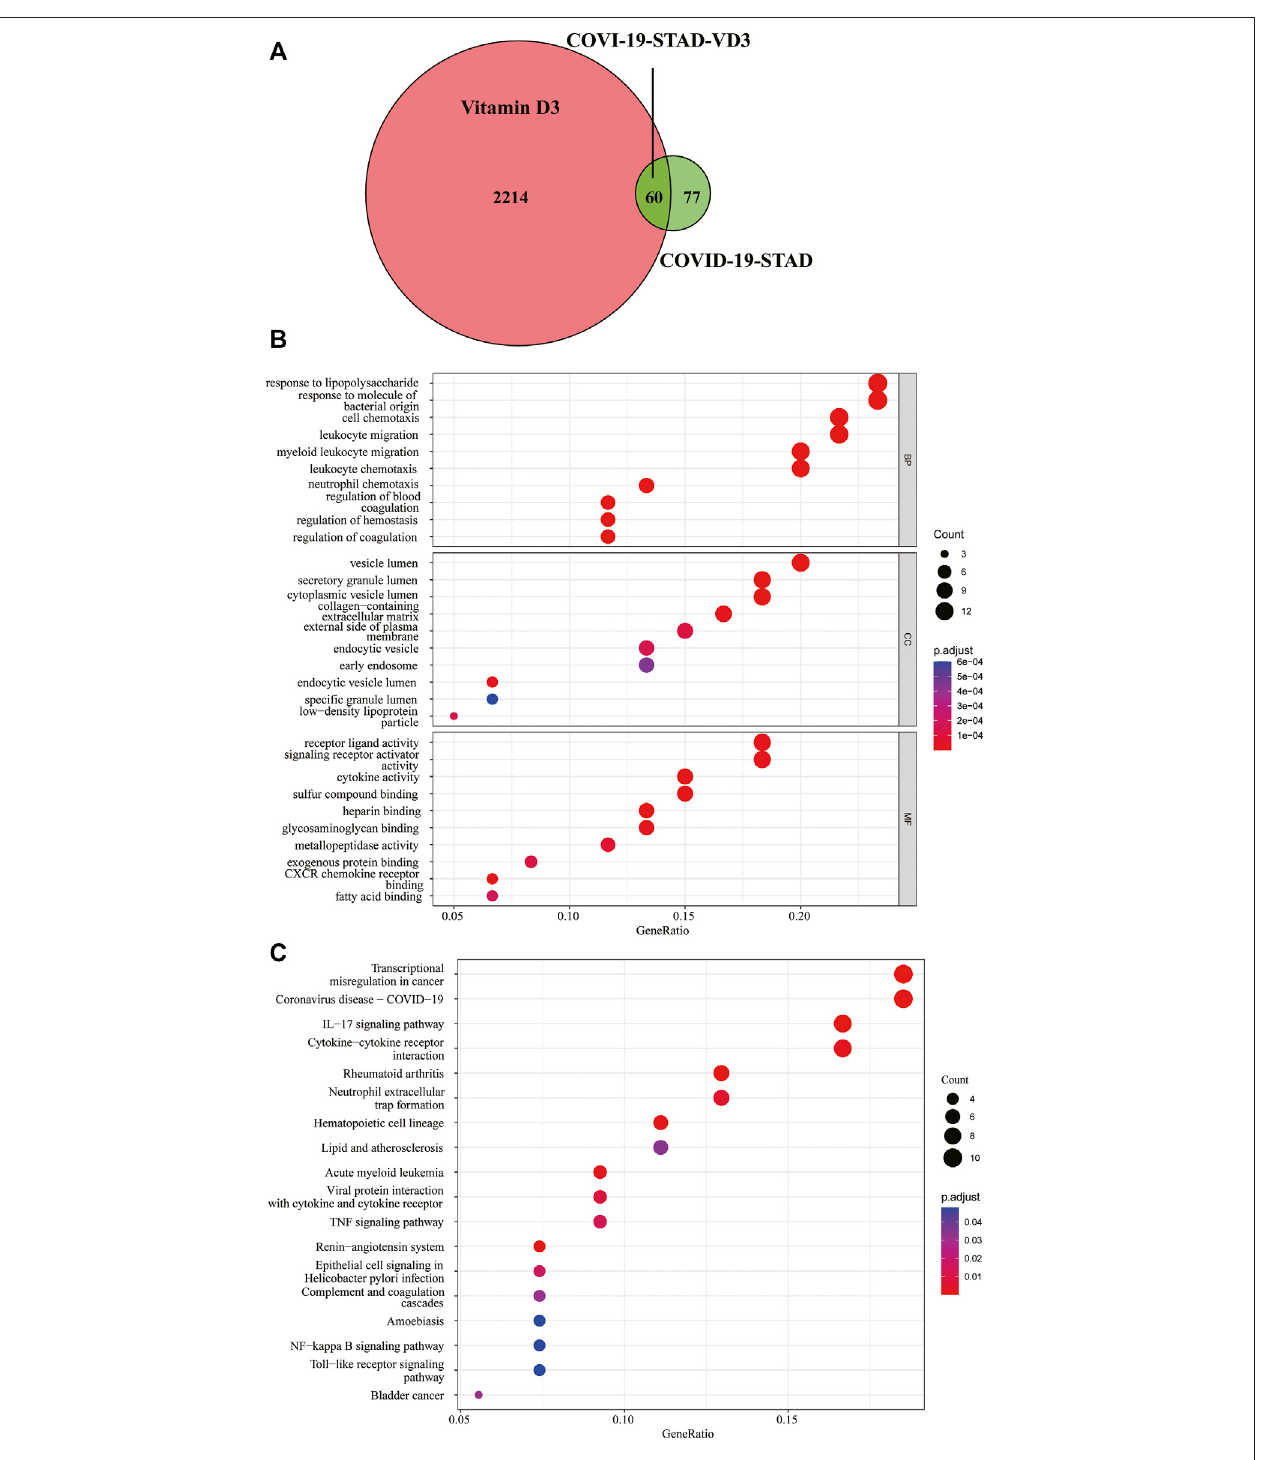
FIGURE 4 | Functional characterization of VD3 against STAD/COVID-19. (A) Venn diagram of VD3 and STAD/COVID-19 Intersecting genes. (B) GO analysis of intersecting genes of VD3 and STAD/COVID-19. (C) KEGG pathway enrichment analysis of intersecting genes of VD3 and STAD/COVID-19.